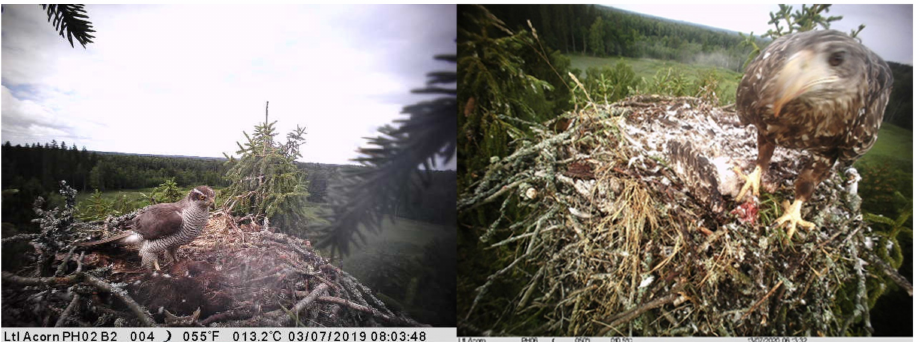
Figure 1. Northern Goshawk ( left ) and White-tailed Eagle ( right ) on the Osprey nests with hunted Osprey chicks.